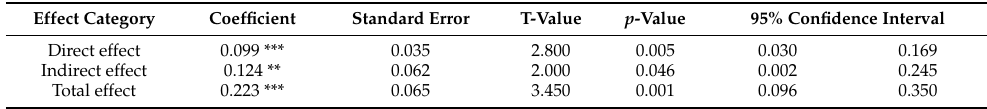
Table 8. Robustness results (economic weight